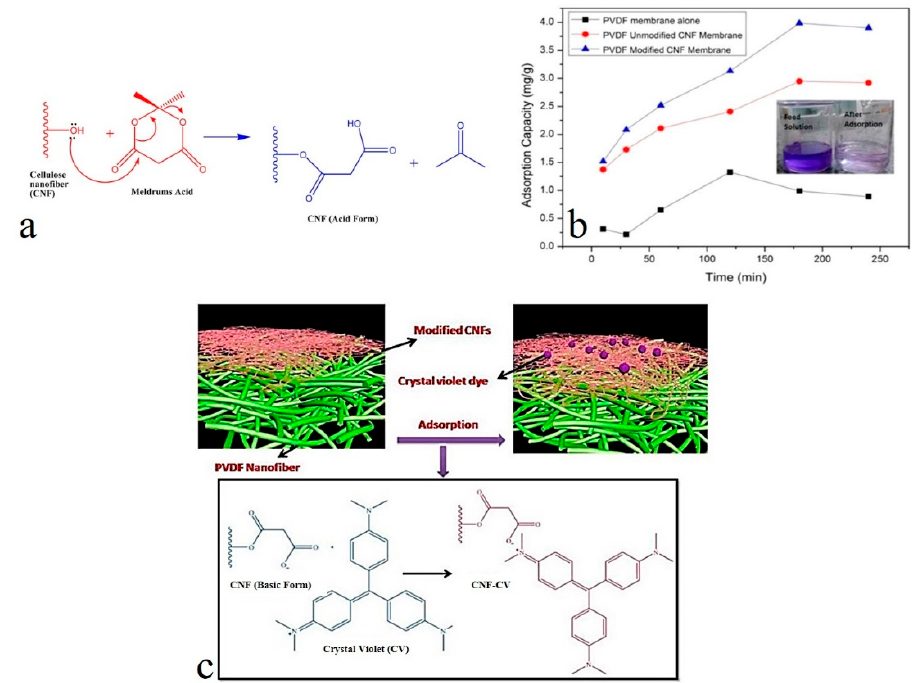
Figure 7. ( a ) The functionalization reaction that engenders the Meldrum’s acid modified cellulose nanofiber. ( b ) Time-dependent CV adsorption efficiency of the Meldrum’s acid modified cellulose